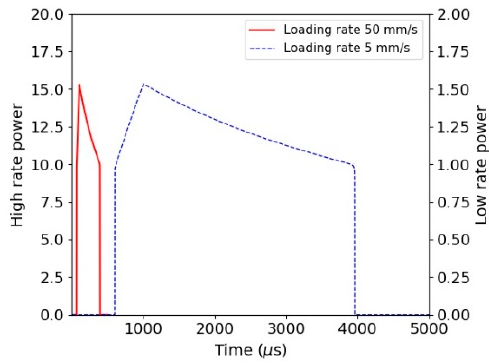
Figure 13. Constitutive model. ( a ) Behaviour for single element test; ( b ) temperature vs damage.